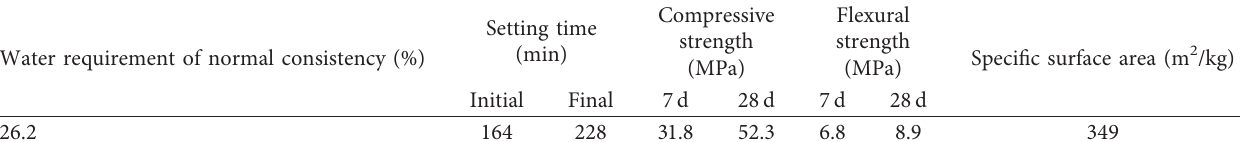
Table 1: Main physical properties of cement.